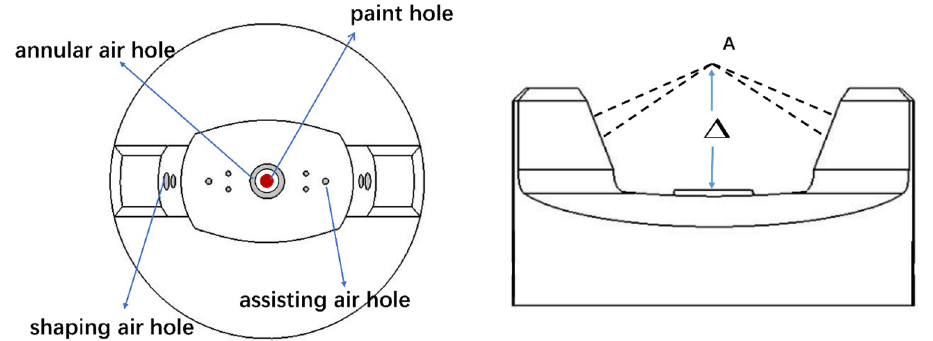
Figure 1. Pneumatic atomizer geometry. (A is the intersection of the shaping air holes, Δ is the distance between the intersection and the paint hole) .